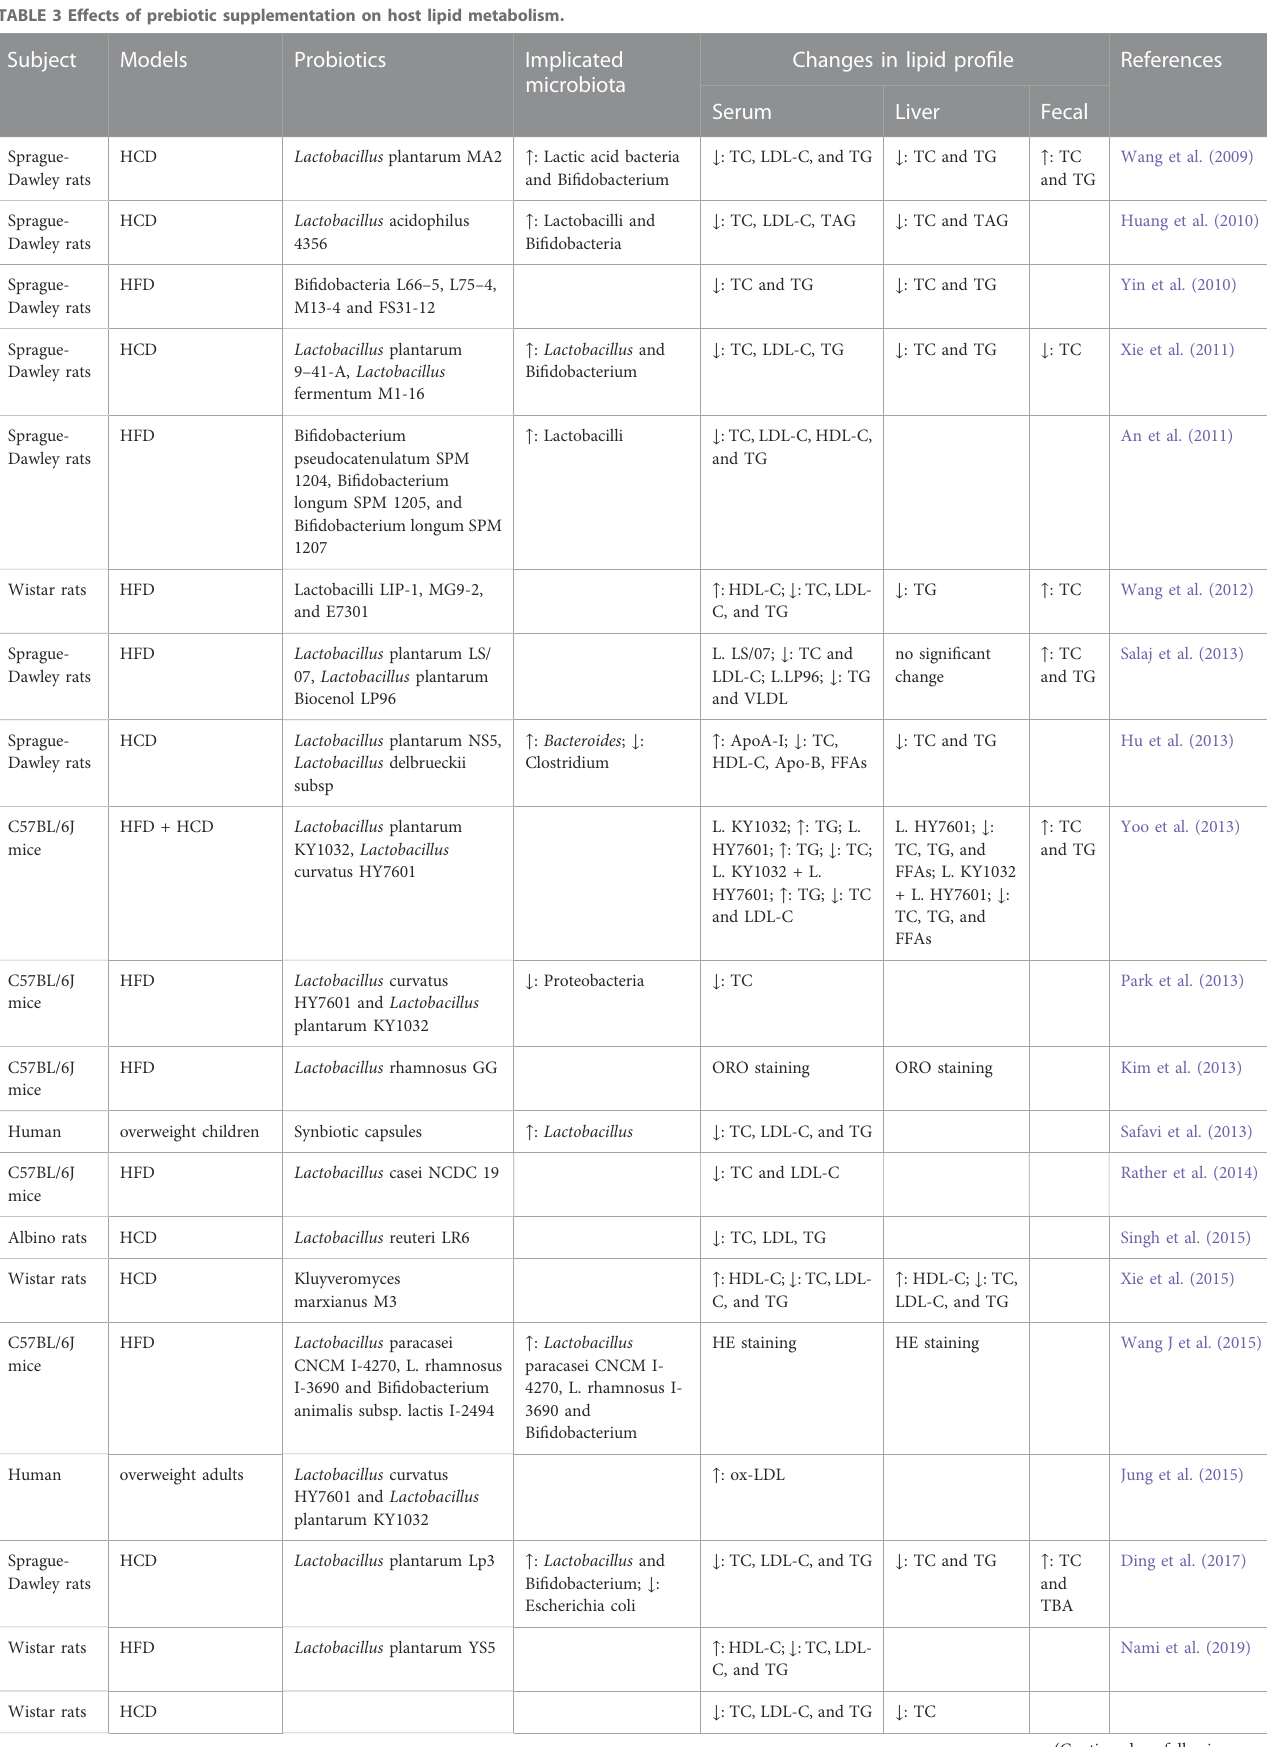
TABLE 3 Effects of prebiotic supplementation on host lipid